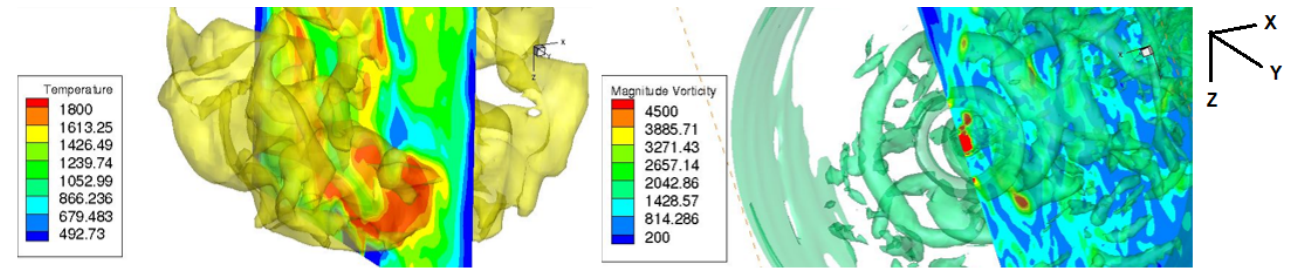
Figure 11. Snapshot of isosurfaces at temperature T = 1600 ◦ C ( left ) and isovorticity surface ω = 2000 s − 1 ( right ) for